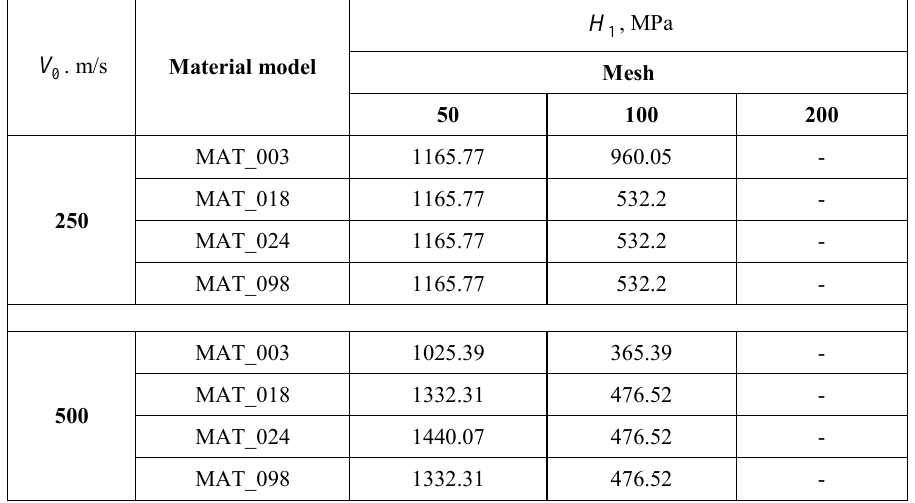
Table 2. It can be seen that with decreasing mesh size at a speed of 1000 m / s, the value of dynamic hardness is almost the same Table 2. The calculated values of dynamic hardness for various speeds, mesh size and type of material (the